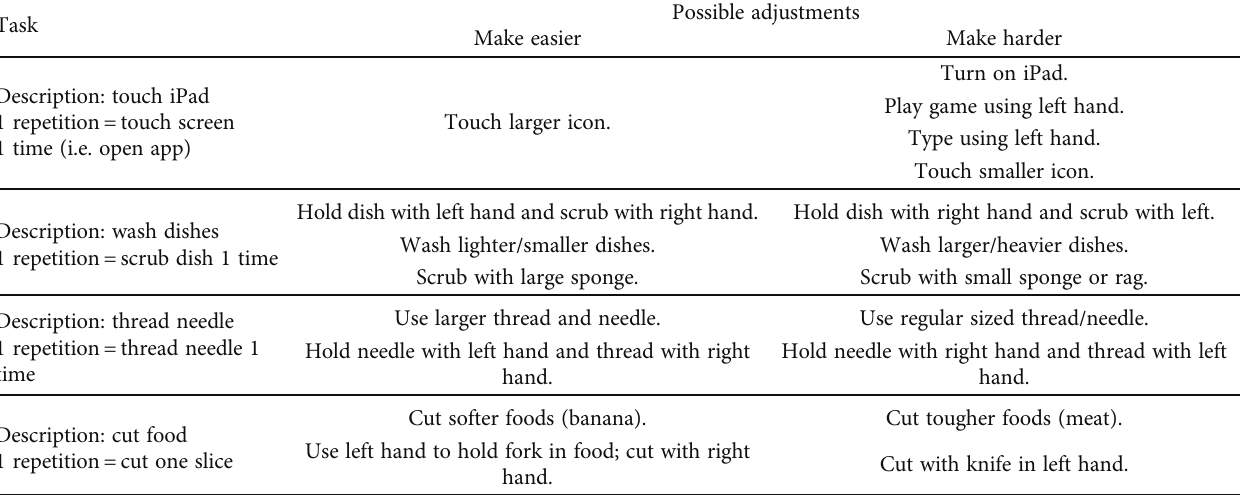
Table 1: Example Home Exercise Program Tasks with Options to Grade.